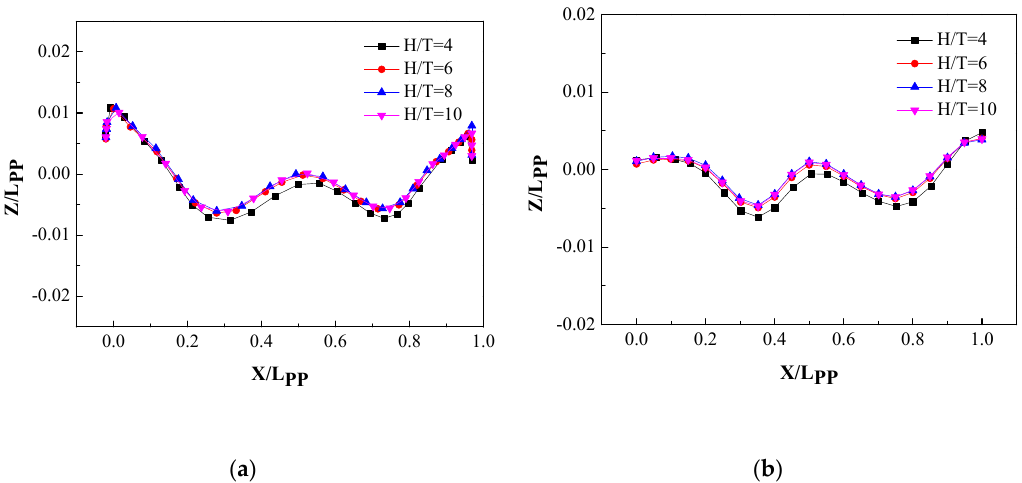
Figure 14. The model-scale wave profiles at different water depths: ( a ) on the hull surface and ( b ) on the Y = 0.1509 Lpp section.